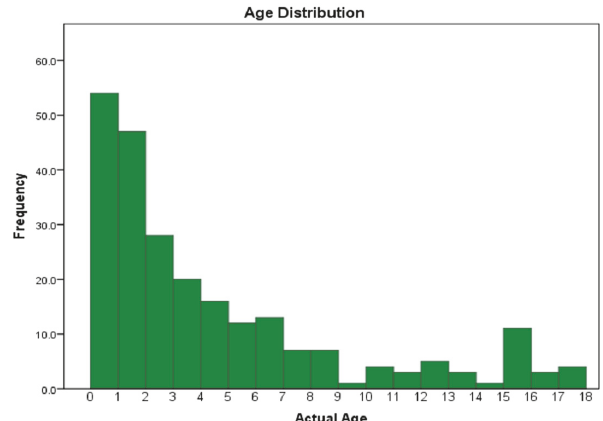
Figure 1: Age distribution for all children diagnosed with neck